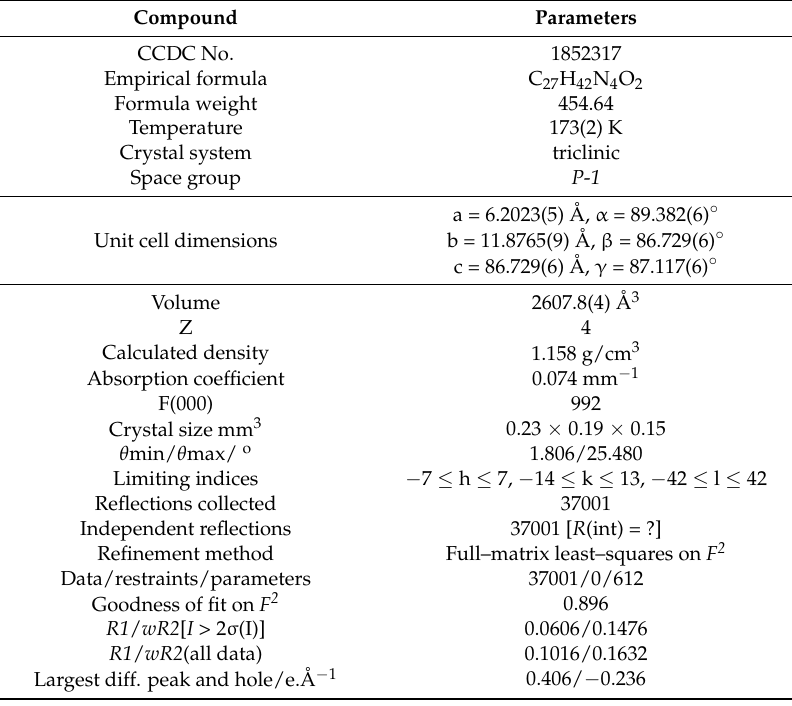
Table 1. Crystal data and structure refinement for 4TBP-TATU aggregate.